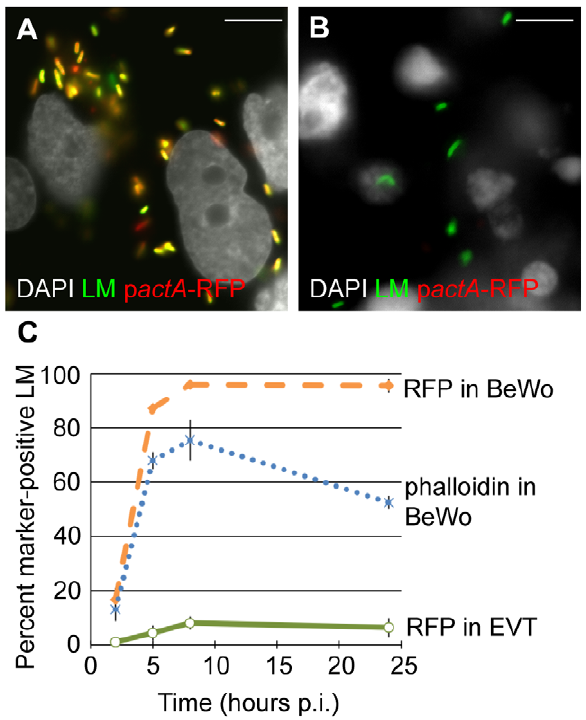
Figure 3. Vacuolar escape of L.monocytogenes (LM) is strongly impaired in EVT. BeWo cells and EVT were infected with p actA -RFP LM and counterstained with anti-LM antibody (green). ( A,B ) Represen- tative images of BeWo ( A ) and EVT ( B ) 8 hours post-inoculation (p.i.). DAPI counterstain (white). Scale bar is 10 m m. ( C ) Percent RFP- expressing bacteria were enumerated and represent bacteria that escaped from the primary vacuole. Actin nucleation by wild type LM in BeWo cells was measured by co-localization with phalloidin. Bacterial RFP expression and phalloidin-co-localization are expressed as a percentage of the total number of intracellular bacteria. Each data point is an average of 3 independent experiments. Bars represent SEM.